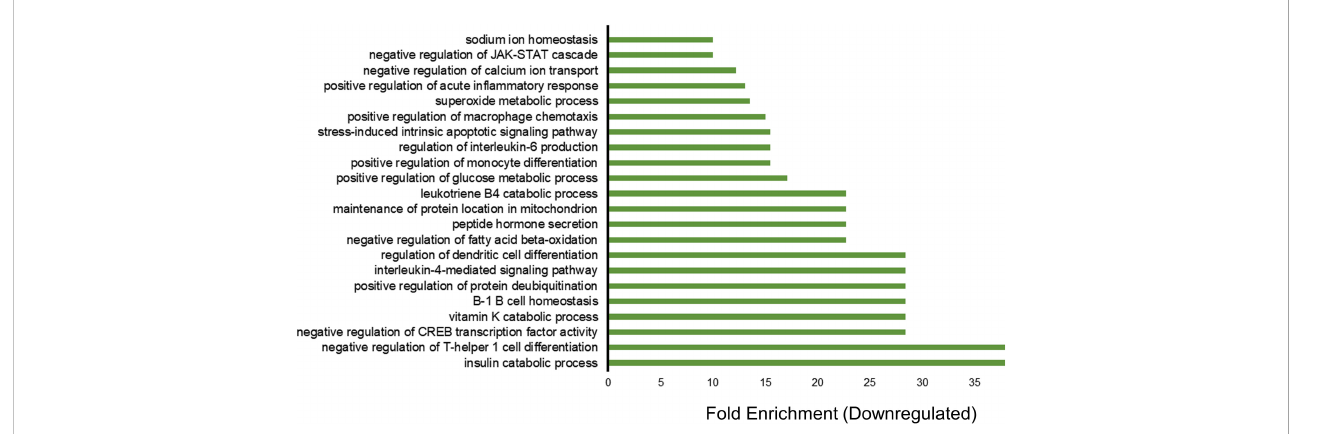
FIGURE 2 Transcriptome pro fi ling of down-regulated genes in patients treated with vagus nerve stimulation. Gene ontology (GO) enrichment analysis of downregulated genes with P value of less than 0.05 and fold change of less than 0.5 are included in the fi gure. The bars represent the different GO categories ordered by enrichment fold change shown on the x axis. The category with the highest fold enrichment is at the bottom of the graph, while the lowest one is at the top of the